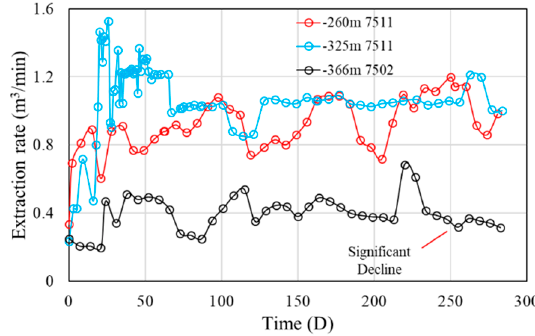
Figure 9. Variations of methane extraction rate of the whole boreholes with time.